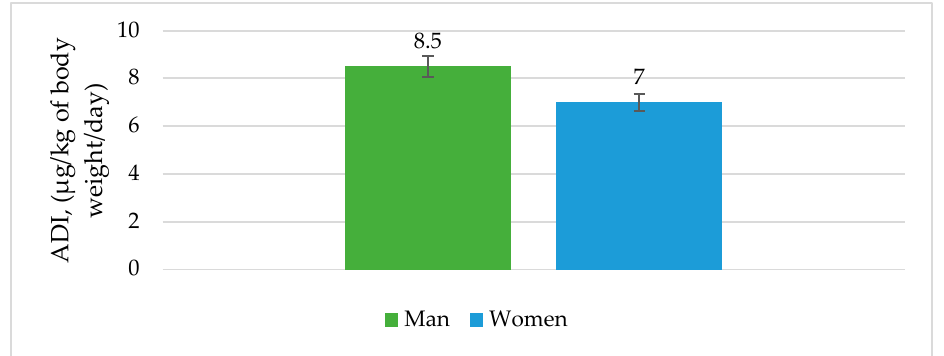
Figure 2. Acceptable daily intake (ADI) through freshwater fish consumption by men and women in Europe.